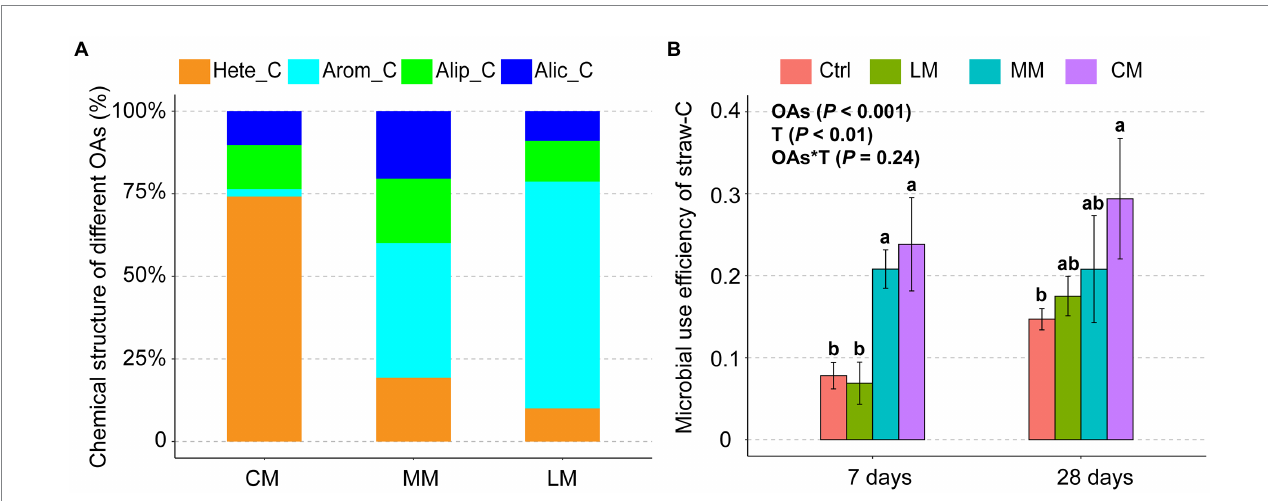
FIGURE 1 Effects of organic amendments (OAs) with different chemical structures on microbial use efficiency of straw-C. (A) The chemical structure of different OAs. (B) The microbial use efficiency of straw-C under different OAs. Data are presented as means ± SD ( n = 3). Error bars depict standard deviations. Lowercase letters indicate significant differences ( p < 0.05) between the treatments. Ctrl, Control without OAs; LM, Addition of lignin-dominant OAs; MM, Addition of OAs with equal content of lignin and cellulose; and CM, Addition of cellulose-dominant